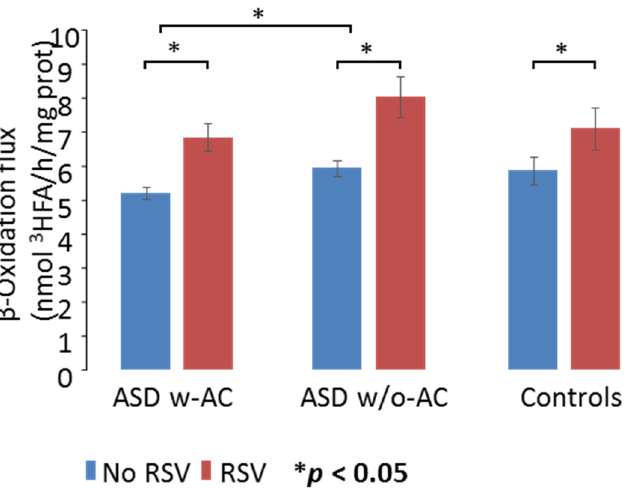
Figure 2. Mitochondrial fatty acid oxidation (FAO) rates (blue bars) and effects of resveratrol (RSV) (red bars) in fibroblasts of ASD patients and healthy control individuals. Figure shows participants with autism spectrum disorder (ASD) that also have acyl-carnitine (AC) elevations (ASD w-AC) and participants with ASD without AC elevations (ASD w/o-AC) as well as control participants. Under basal conditions, the β -oxidation flux (nmol 3 HFA/h/mg protein) measured in fibroblasts of patients with ASD w-AC were significantly decreased compared with the ASD w/o-AC. RSV significantly increased mtFAO values in all the study groups. The results are means (±SD) of three different experiments. * p < 0.05.